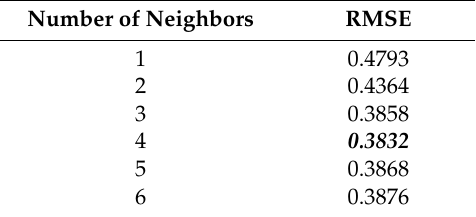
Table A1. Sensitivity of instance-based learning algorithms (IBK) to the number of neighbors.